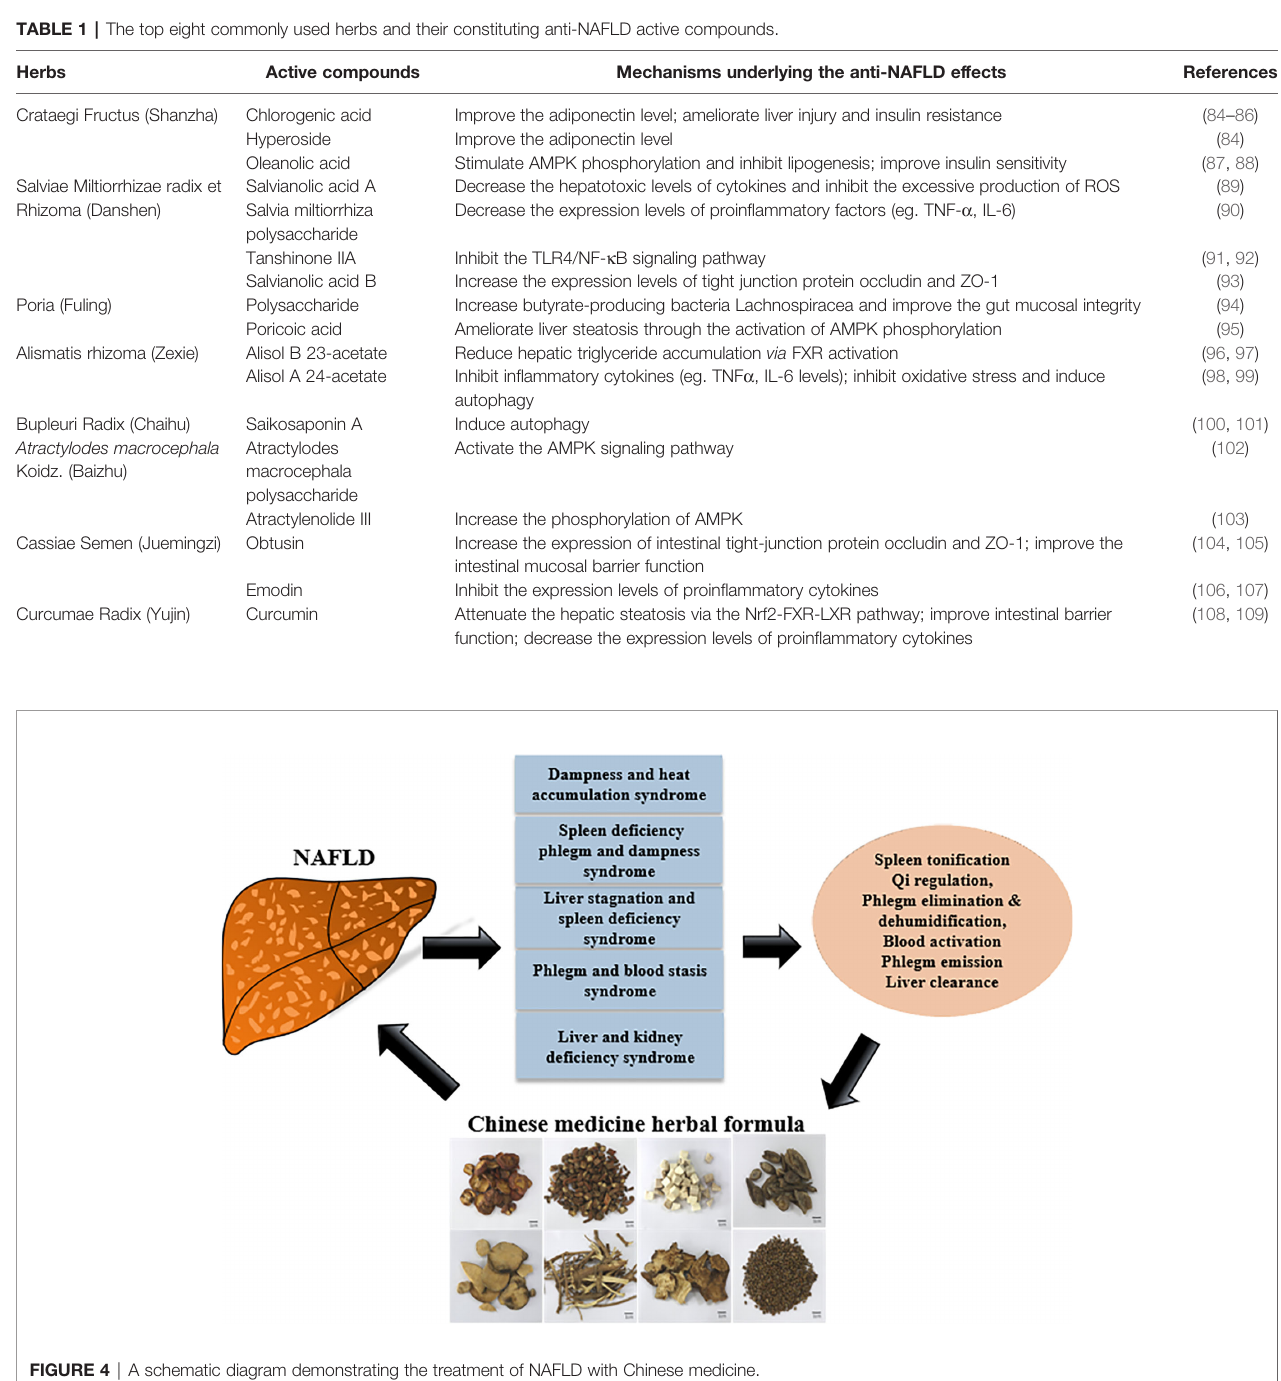
FIGURE 4 | A schematic diagram demonstrating the treatment of NAFLD with Chinese